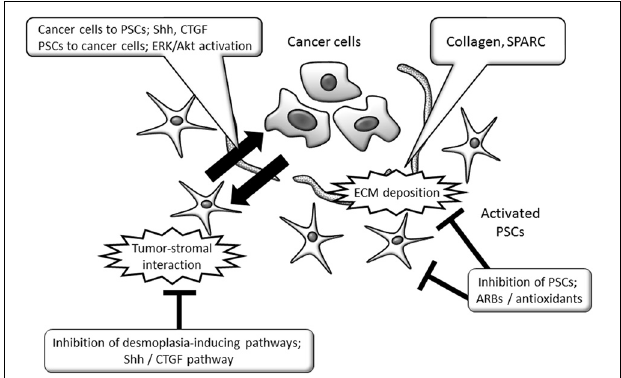
FIGURE 1 | Schematic view of tumor-promoting PSC functions and PSC-targeting strategies in pancreatic cancer. The tumor-promoting interaction between cancer cells and PSCs could be therapeutic targets, by the inhibition of specific signaling pathways or PSC’s functions. ARB, angiotensin II type 1 receptor blocker; CTGF, connective tissue growth factor; ECM, extracellular matrix; ERK, extracellular signal-regulated kinase; PSCs, Pancreatic stellate cells; Shh, sonic hedgehog; SPARC, Secreted protein acidic and rich in cysteine.